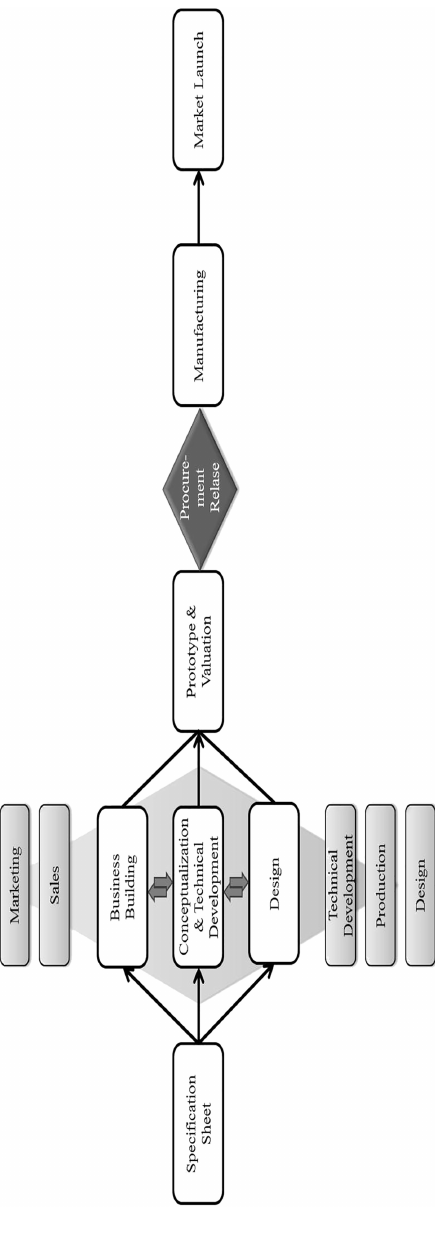
Figure 6. Proposed